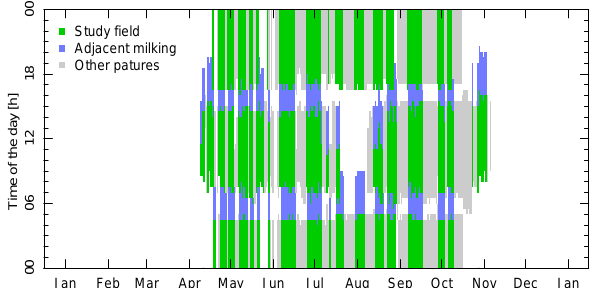
Figure 1. Duration of grazing on the study field (green bars) and for other pastures (gray) over the day and year. The “effective pas- ture time” of 73.1 days (total of green bars) plus the adjacent “off- pasture time” for milking of 25.9days (blue bars) resulted in “total grazing days” of 99days. White areas mark other times spent in the barn. White and gray bars are not considered in the budget calcula- tion. texture and a C content of the upper soil layer (0 to 20 cm) of 29 g kg − 1